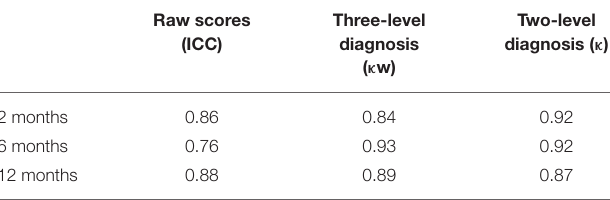
TABLE 1 | Inter-rater agreement for raw scores, two-level and three-level diagnosis at 2, 6, and 12 months. Raw scores